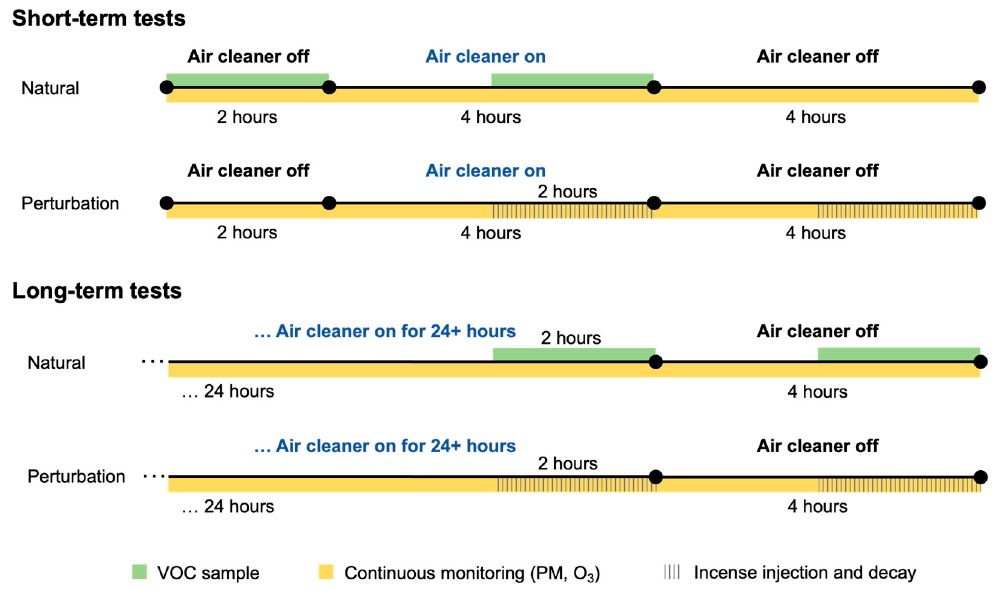
Figure 2. Typical timeline of testing and sampling in the chamber experiments in Chicago, IL, USA.